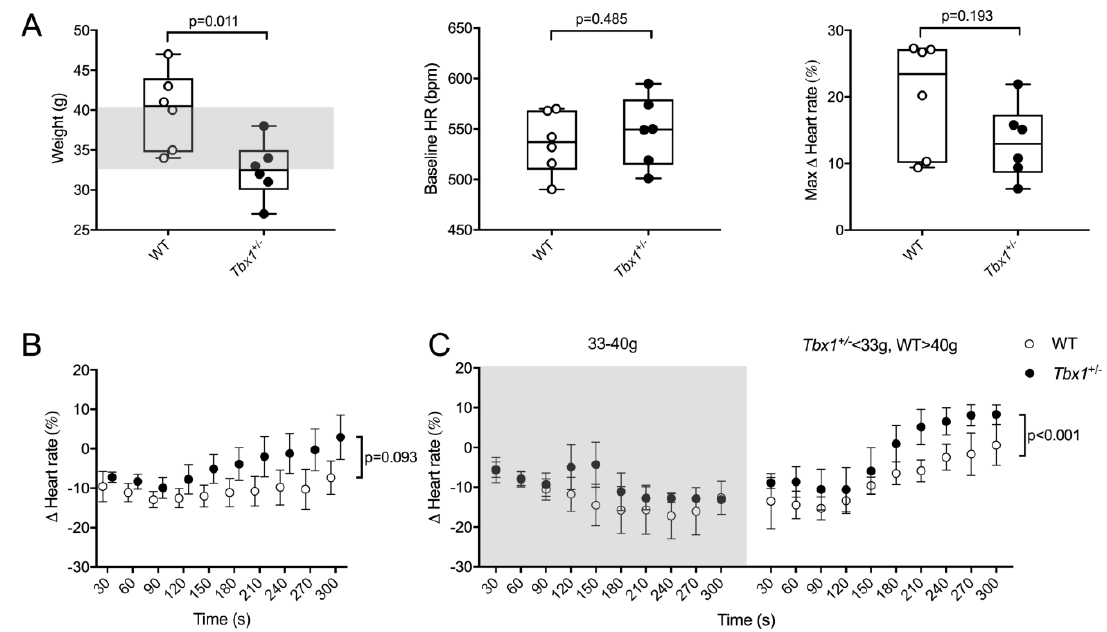
Figure 4. ( A ) Box and whiskers plots of body weight, baseline HR and maximum HR change; ( B ) Heart rate recovery profile following administration of carbachol in 6 WT and 6 Tbx1 +/− animals (CBC 0.1 mg kg −1 i.p.); ( C ) Heart rate recovery profile of animals categorised by weight. Shaded area represents range in between median weights of WT and Tbx1 +/− animals.